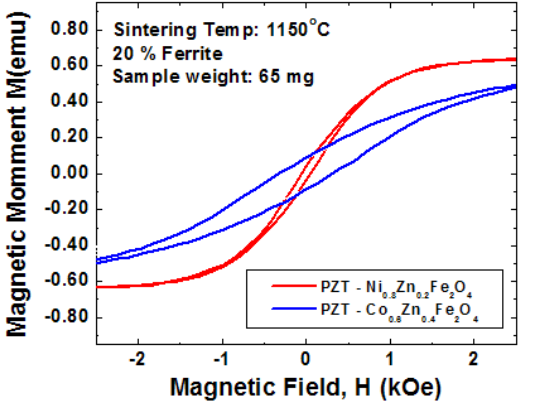
Figure 15. Comparison of magnetic properties for PZT-NZF and